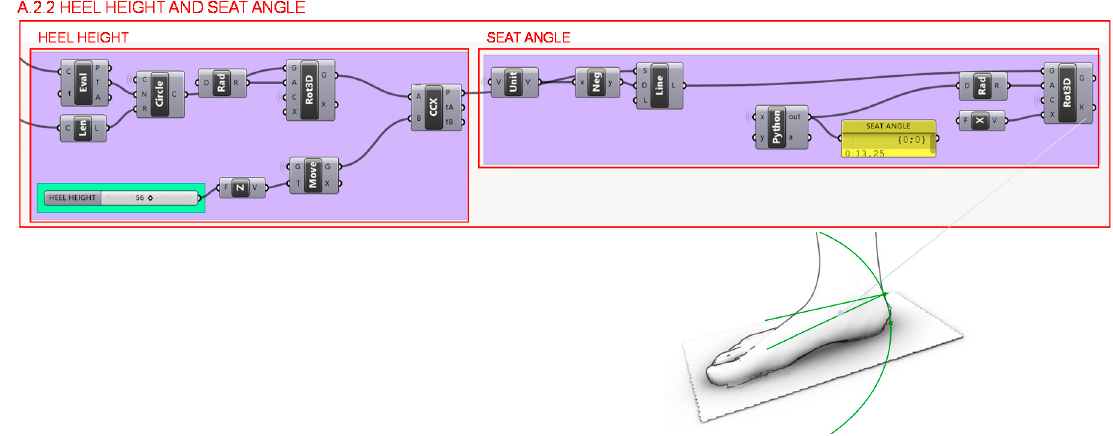
Figure 10. Programming structure definition to determine the heel height and its most suitable seat angle.